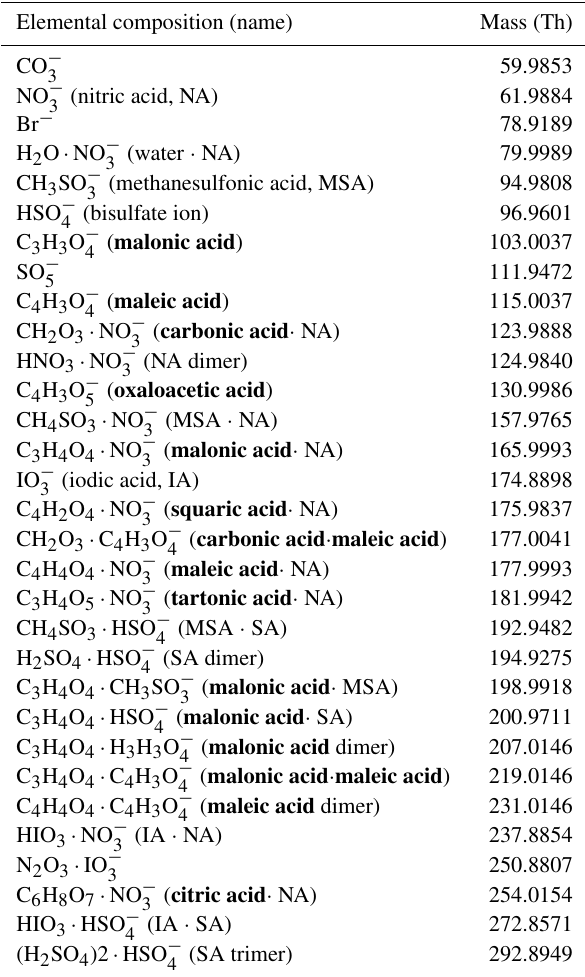
Table A2. Identified compounds of free troposphere (FT) on 16 May 2017 during early morning between 04:00–05:00 EET. The FT was measured on two different height levels (1500 m and 2600 m). Compounds, which contain at least one carboxyl functional group are highlighted